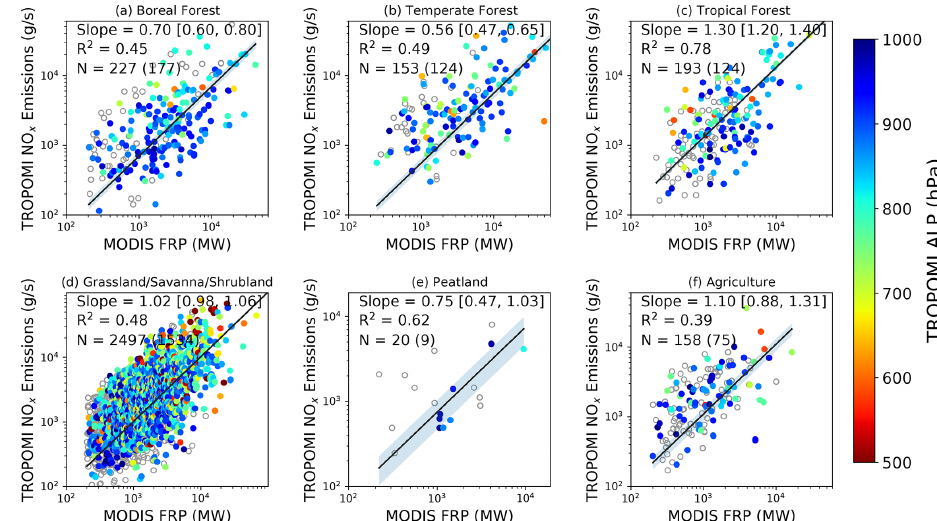
Figure 3. Scatter plots between TROPOMI-derived NO x emissions (gs − 1 ) and MODIS FRP (MW) for six fuel types: (a) boreal forest; (b) temperate forest; (c) tropical forest; (d) herbaceous fuel type that combines grassland, savanna, and shrubland together; (e) peatland; and (e) agricultural fires. The colors represent the TROPOMI ALP of the corresponding fire events. Fire events without valid ALP are shown as black circles. The black line indicates the regression line estimated from ordinary least squares with the intercept fixed at zero. The shadow represents the 95% CI of the fitted line, calculated based on the Student’s t -distribution test. R 2 is the coefficient of determination of the linear fit. N is the number of fire events, and the number of fires with valid TROPOMI ALH is in the parenthesis. Emissions and FRP are on log